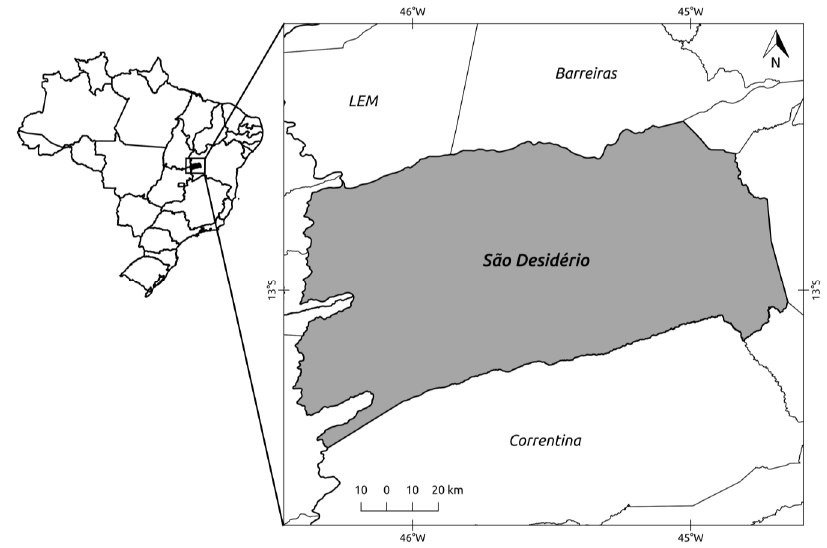
Figure 1. Location of the study area. LEM is the municipality of Luís Eduardo Magalhães.